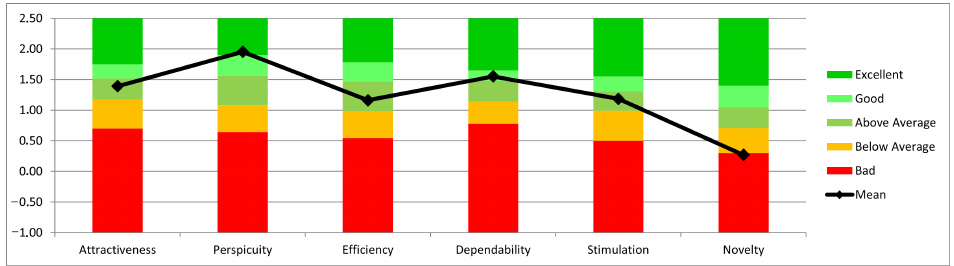
Figure 9. User experience questionnaire (n = 37). Table 3. Scales UEQ confidence intervals ( p = 0.05) per scale (n = 37). Scale Mean Std. Dev. Confidence Confidence